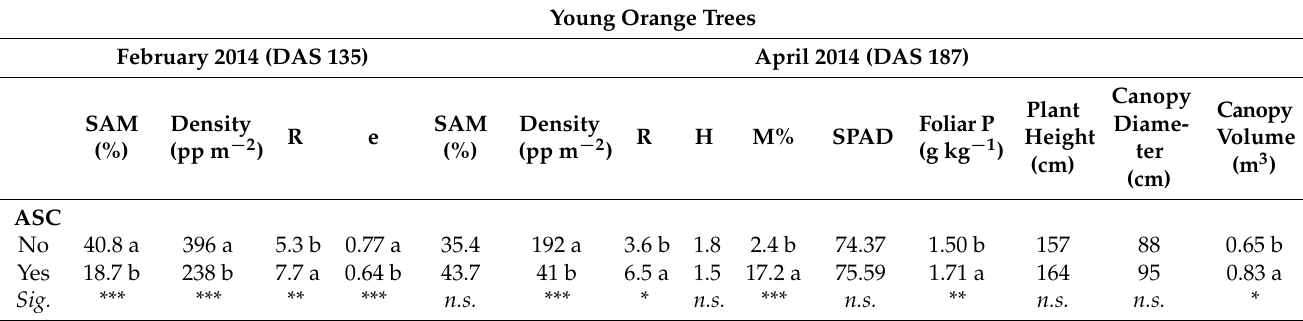
Table 3. Frequencies of species with confirmed mycorrhizal association (SAM%), weed density (pp m − 2 ), specie Richness (R), Shannon–Weaver index (H) and mycorrhizal colonization intensity (M%), foliar SPAD, foliar P (g kg − 1 ), plant height (cm), canopy diameter (cm) and canopy volume (m 3 ), recorded in 2014 on young orange trees organic production system. ASC: agroecological service crop (barley). Levels of statistical significance ( p -value) are: * p < 0.05, ** p < 0.01 and *** p < 0.001 (ANOVA). Different letters represent significant differences (Tukey’s HSD test for means